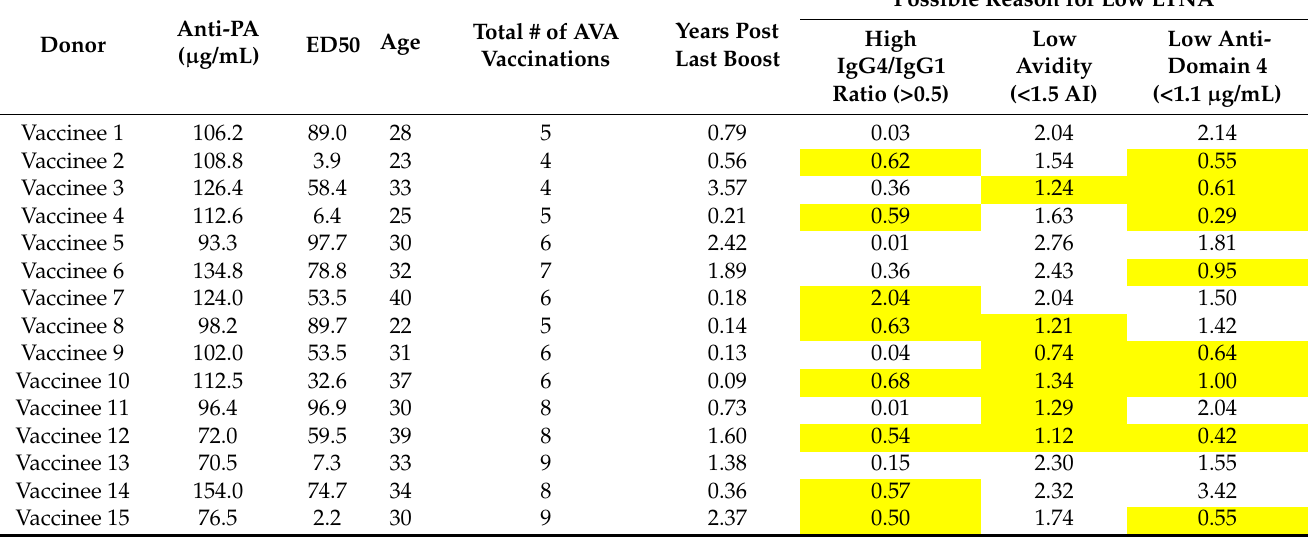
Table 2. Possible reasons for low neutralization capacity for each vaccinee in the low LTNA group. The boxes colored yellow indicate a possible reason using the cutoffs of (>0.5 for IgG4/IgG1 ratio, <1.5 for AI, and <1.1 for anti-domain 4). These cutoffs correspond to exceeding the maximum value of the high neutralizers (IgG4/IgG1 ratio) or minimum value of the high neutralizers (AI and anti-domain